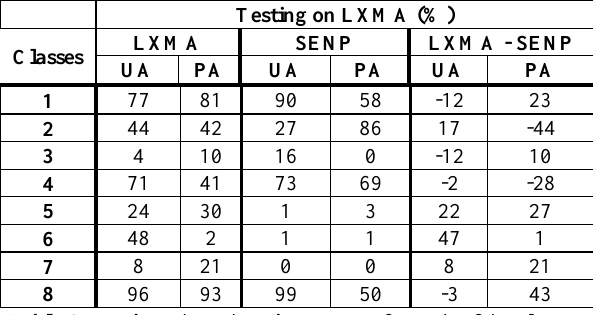
Table 6. User’s and Producer’s accuracy for each of the classes, considering each of the training datasets, LXMA and SENP; testing only LXMA dataset.